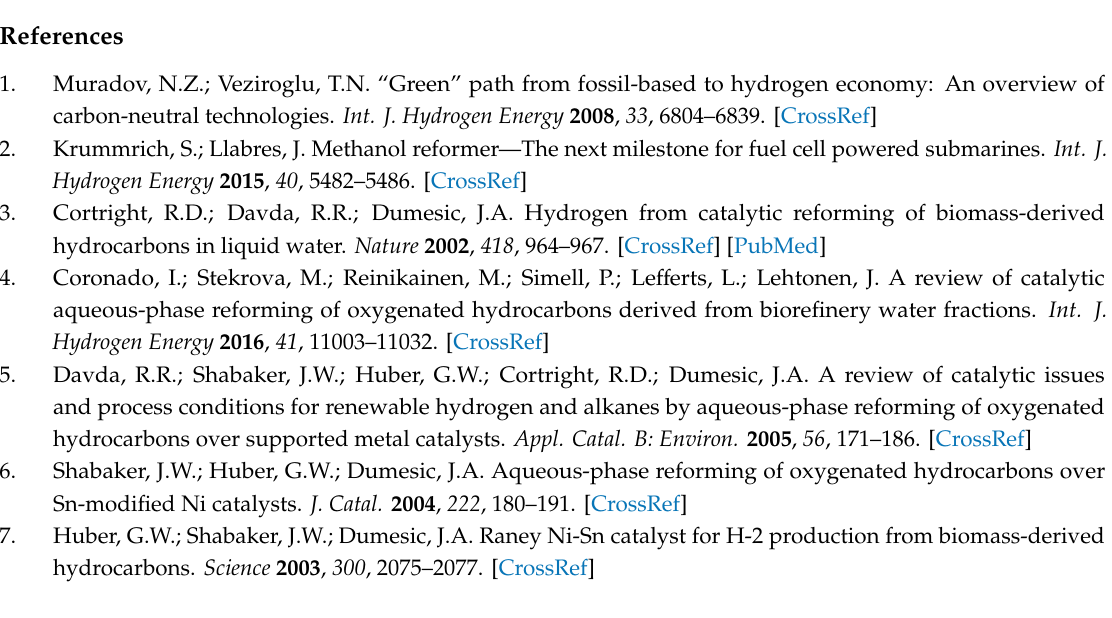
Figure S1: Experimental setup for APR of methanol, Figure S2: N 2 adsorption-desorption isotherms, Figure S3: CO 2 -TPD profiles showing deconvoluted peaks, Figure S4: Ce 3d XPS spectra, Figure S5: O 1s XPS spectra,